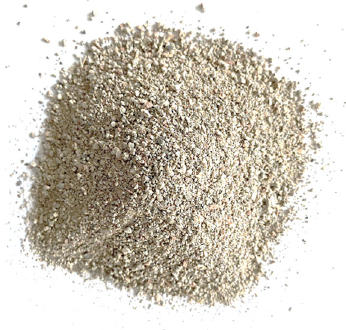
Figure 1. CDW-A, commercialized by a Portuguese treatment and recycling plant.